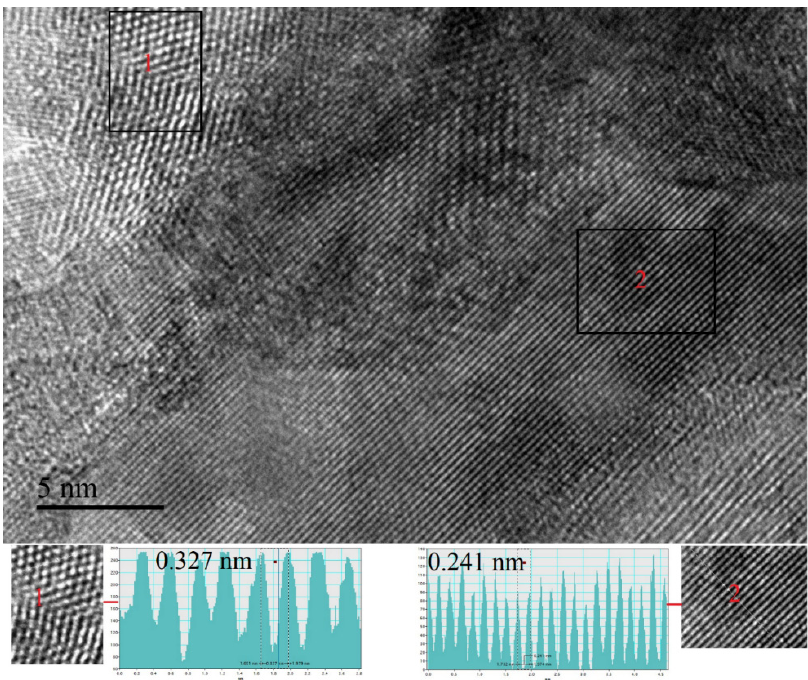
Figure 3. HRTEM image of Fe 9 TiO 15 @TiO 2 nanocomposite and IFFT analysis of the marked areas.